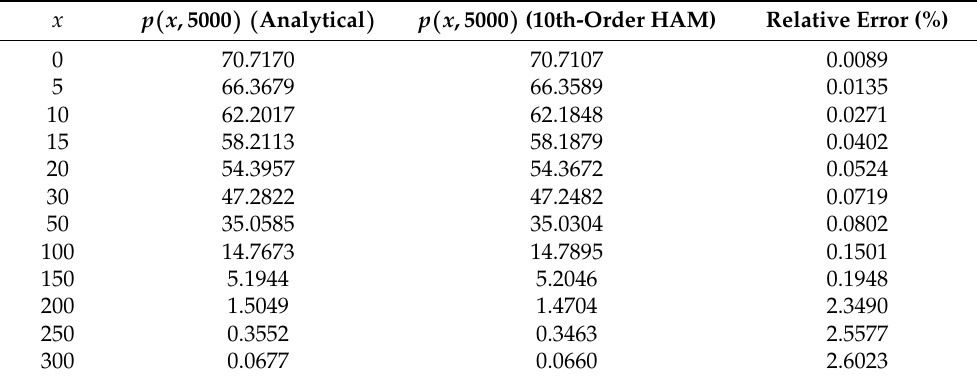
Table 1. Comparison of the results of dimensionless formation pressure p ( x , t ) of 10th-orderHAM and the exact analytical solutions when λ = 0, U = 0.5, t = 5000.